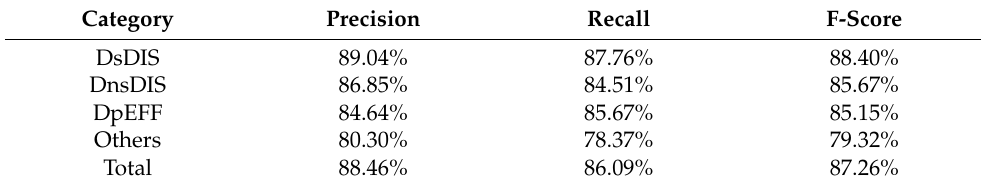
Table 2. The performance of BERT-BiGRU-ATT on the test set.